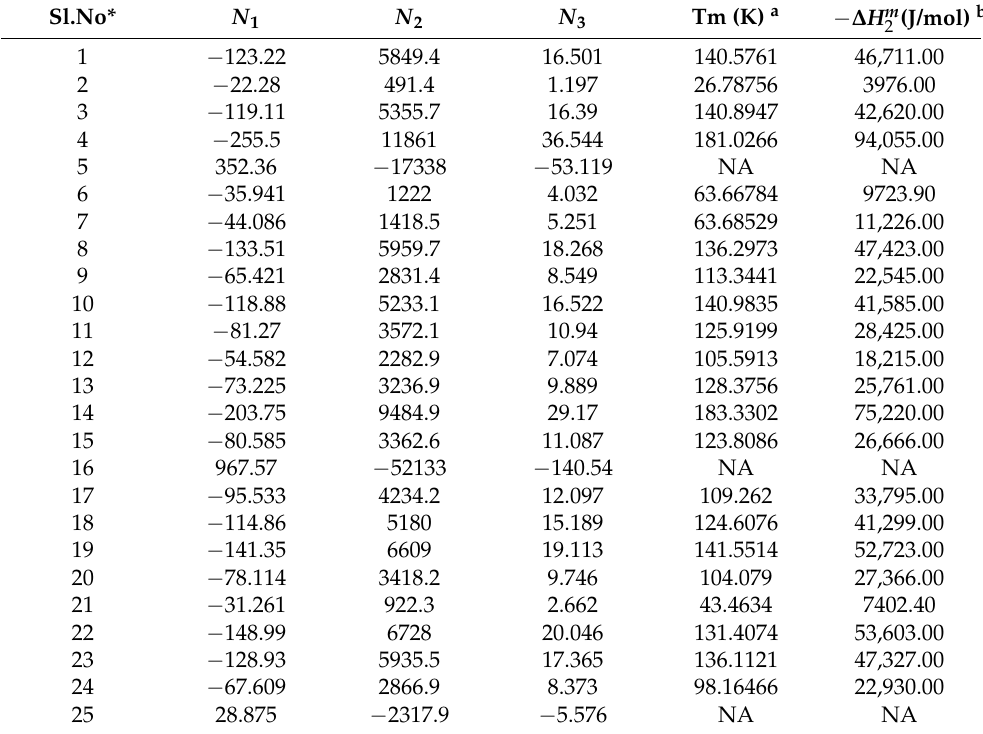
from new model 1. 2